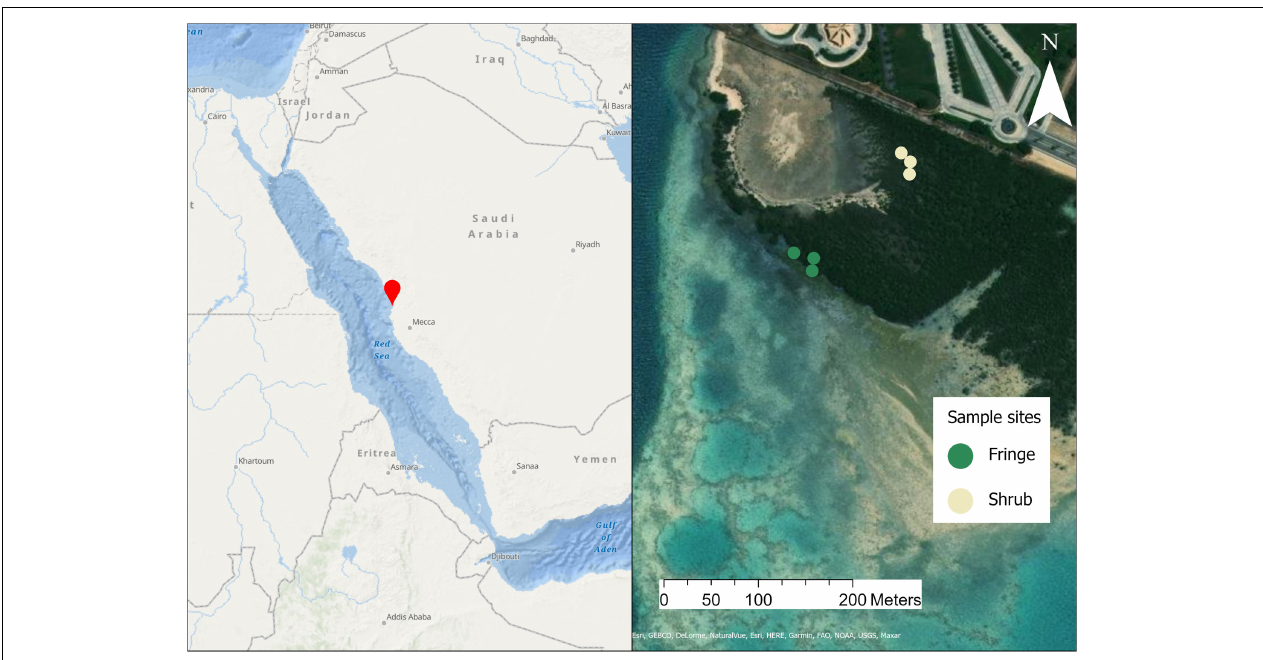
FIGURE 1 | Map of the study area. The left side shows the site location in the central Red Sea. On the right is a satellite image of the sampling site showing the contrasting zones. From each indicated location (colored dots) three replicate samples were collected. The established sites were sampled once during each season sampling campaign. Sources: Esri, GEBCO, NOAA, National Geographic, DeLorme, HERE, Geonames.org, and other